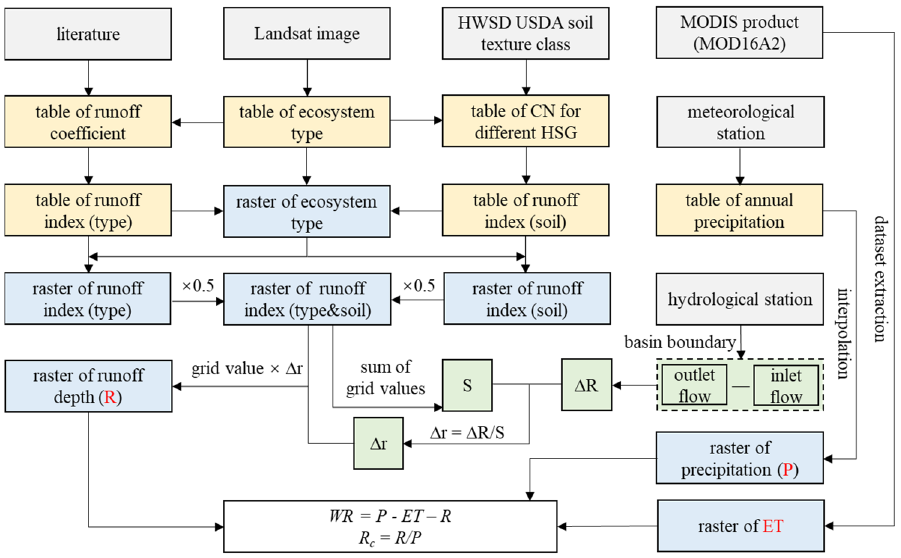
Figure 2. Technical fl owchart.